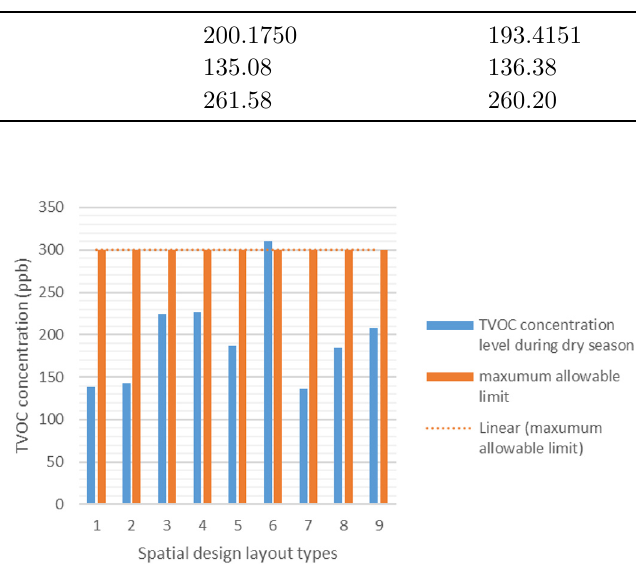
Fig. 7. PM 10 concentration levels in the different spatial design layouts during wet season.